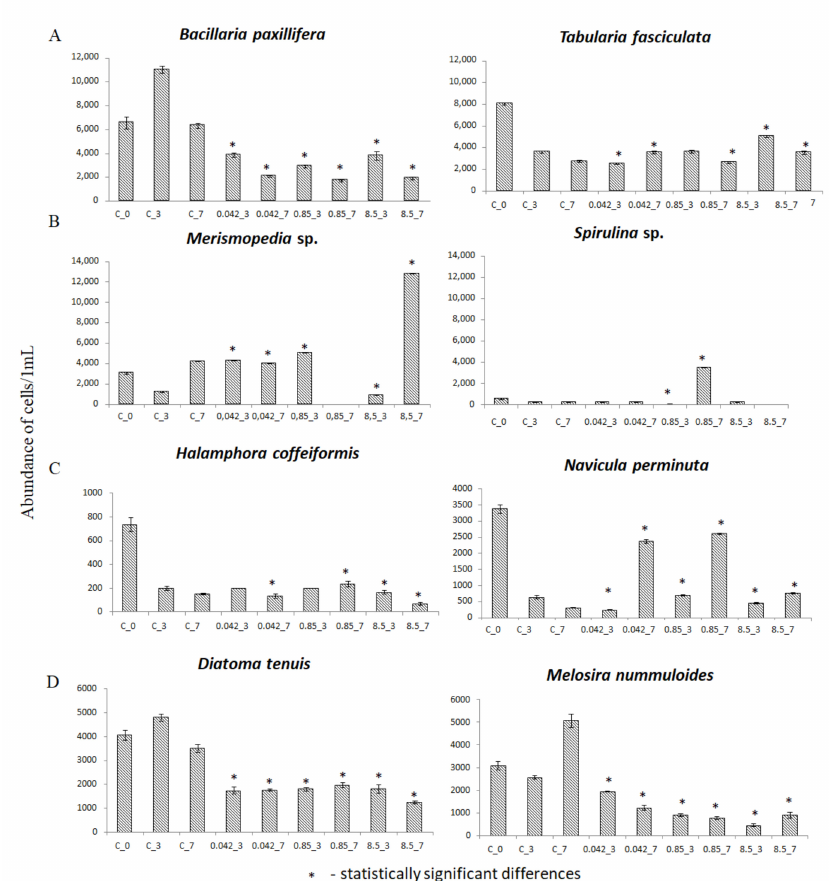
Figure 4. Abundance of cells of selected taxa in control solution: C_0—the start of the experiment; C_3—after three days of the test; C_7—after seven days of the test; and in glyphosate concentrations of glyphosate tested of: 0.042 g · dm − 3 glyphosate (0.042_3) after three and (0.042_7) after seven days of tests; 0.85 g · dm − 3 glyphosate (0.85_3) after three and (0.85_7) after seven days of tests; 8.5 g · dm − 3 glyphosate (8.5_3) after three and (8.5_7) after seven days of tests. Statistically significant differences were denoted with the asterisk. ( A )—dominant species on which glyphosate had a negative effect on growth, ( B )—cyanobacteria in which glyphosate stimulated growth selectively, ( C )—resistant